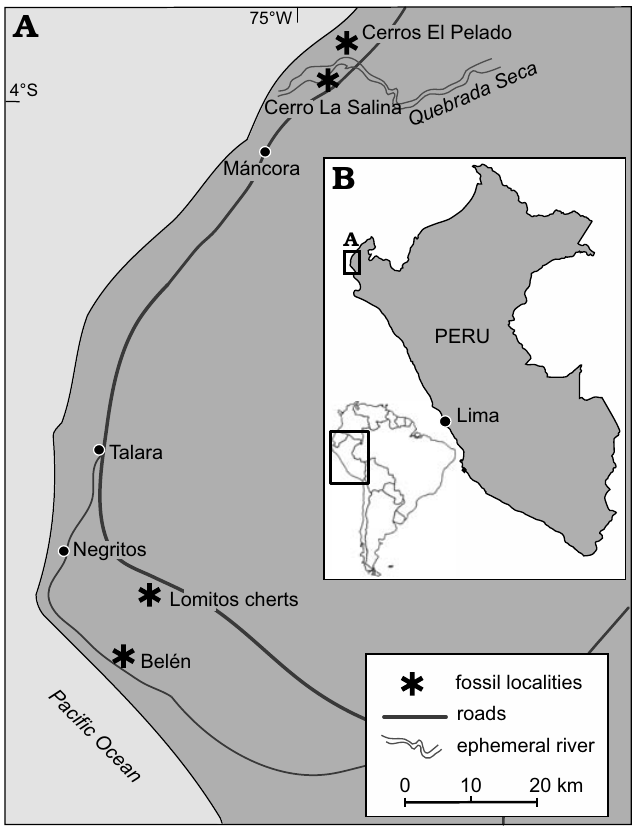
Fig. 1. Locality map of the seep deposits in the Talara Basin in northern Peru, where the here described mollusk and crustacean taxa were found (adopted from Kiel et al.